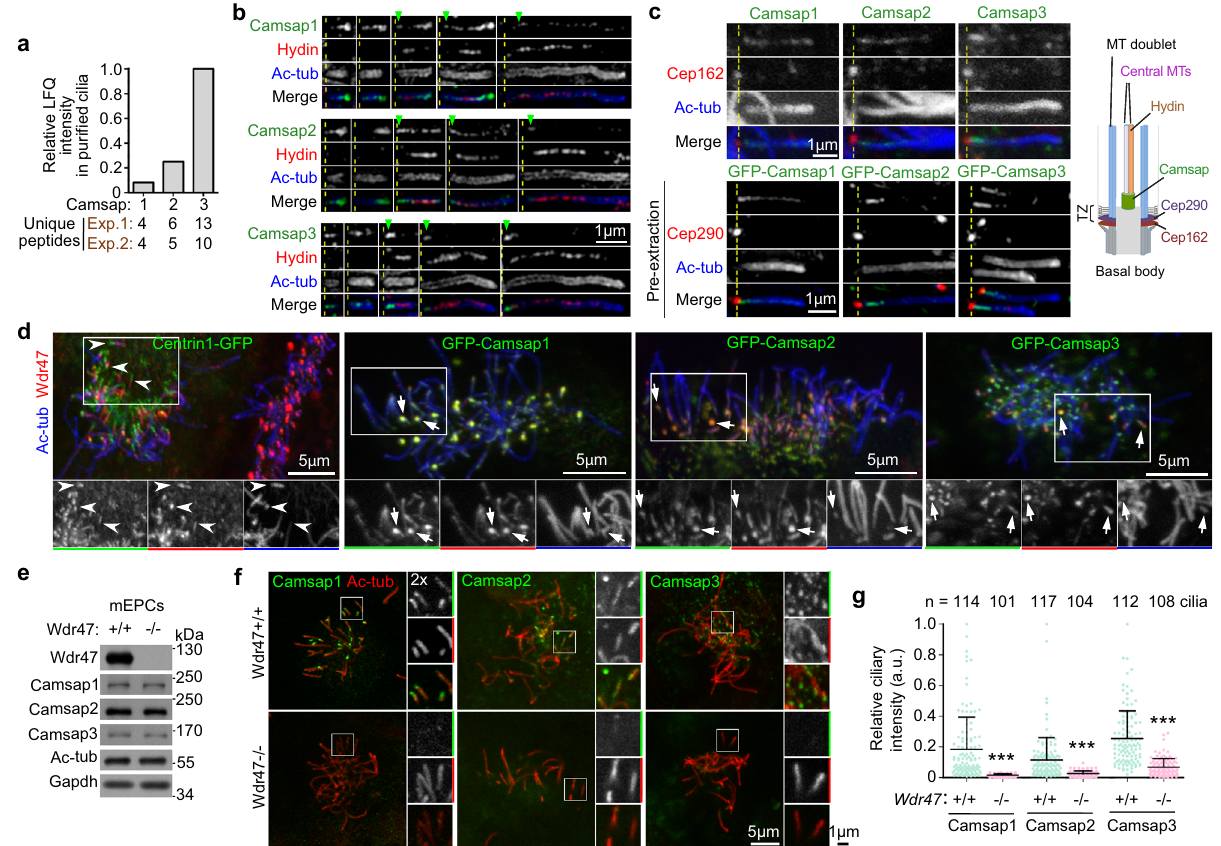
Fig. 4 Camsaps colocalize with Wdr47 in multicilia. a Camsaps were detected in puri fi ed wild-type multicilia by mass spectrometry. LFQ intensities (relative